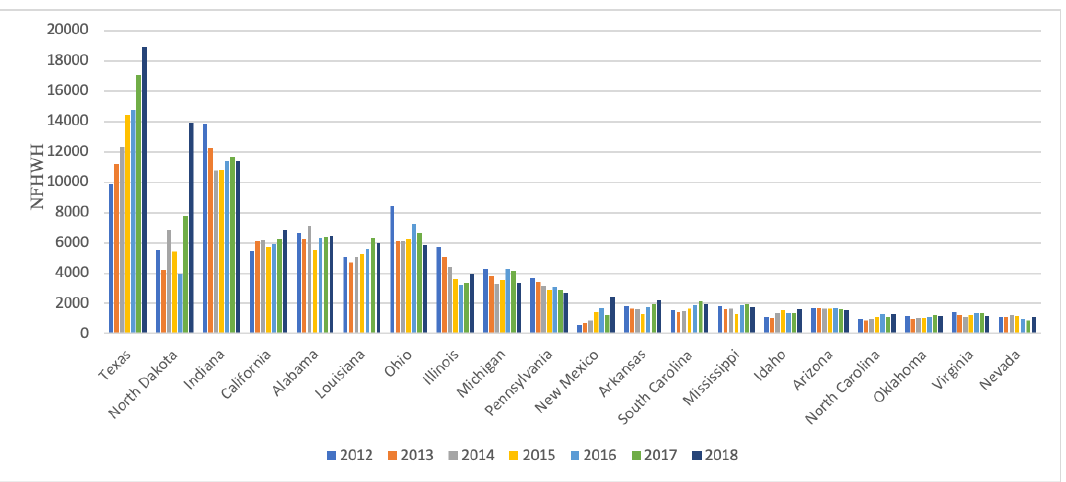
Figure 13. Changes in the distribution pattern of industrial heat releasers across key cities from 2012 to